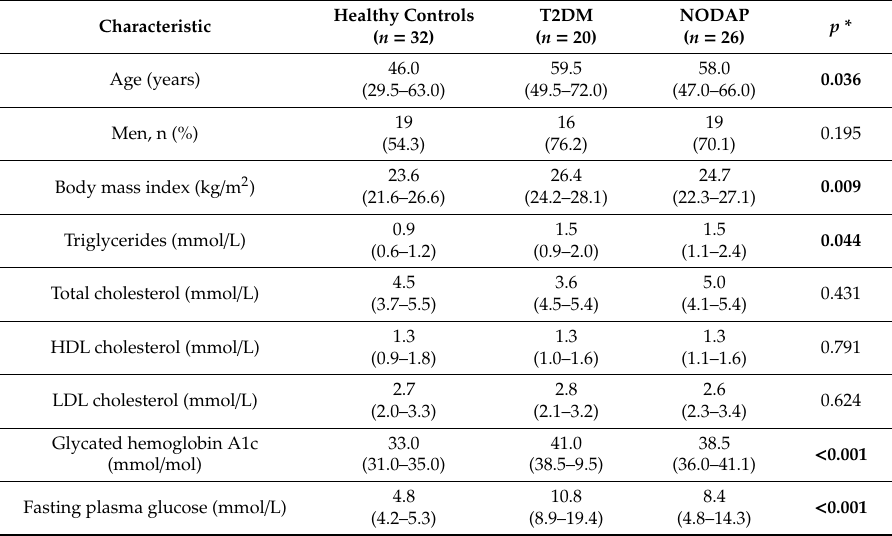
Table 1. Characteristics of the study